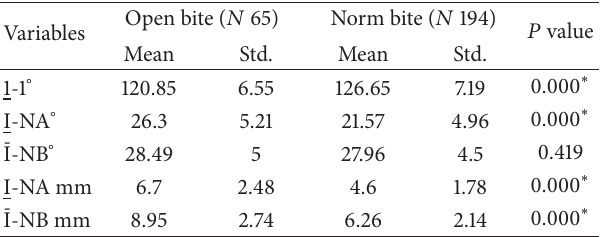
Table 8: Distribution of the dental variable for open bite and norm Yemeni